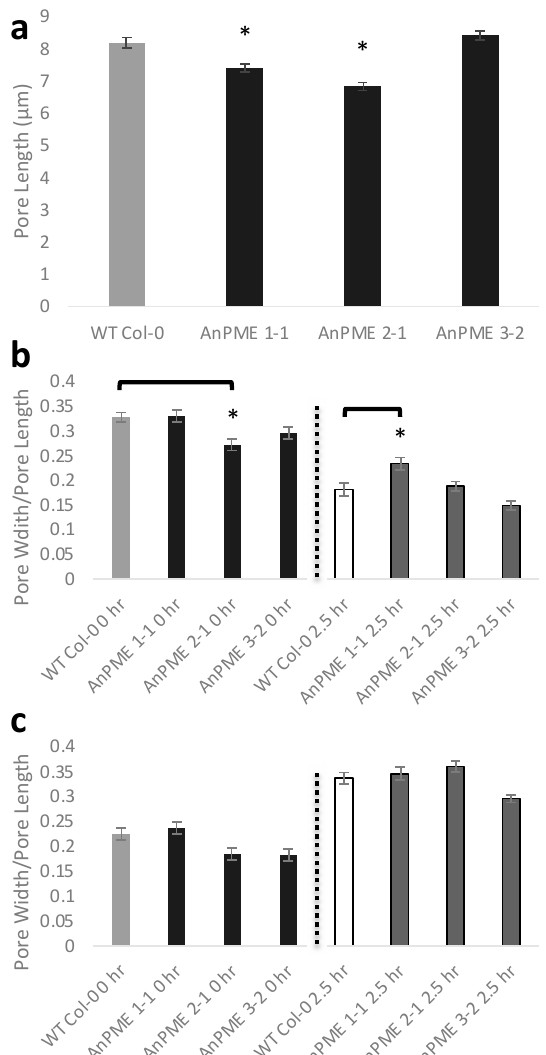
Figure 2. Six-day-old seedlings of AnPME lines show decreased stomatal size but have stomatal functions that are similar to WT. ( a ) Stomatal pore length in WT Col-0 and AnPME lines ( n ≥ 542 stomatal complexes from six independent experiments); ( b , c ) Stomatal responses to dark ( b ) and light ( c ) treatment in WT Col-0 and AnPME lines, represented by pore width to pore length ratio ( n ≥ 124 stomatal complexes from three independent experiments). Error bars represent standard deviation. Asterisks indicate statistical significance ( p < 0.05, one-way ANOVA).